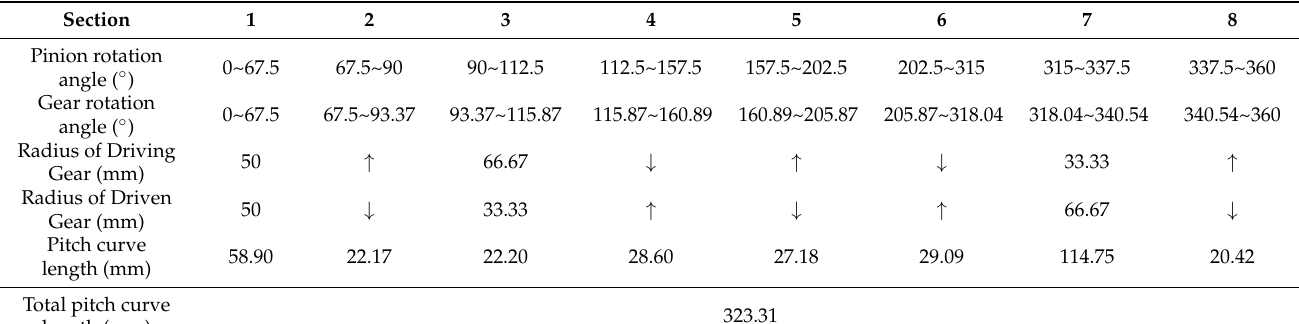
Table 2. Specifications of driving gear and driven gear according to the